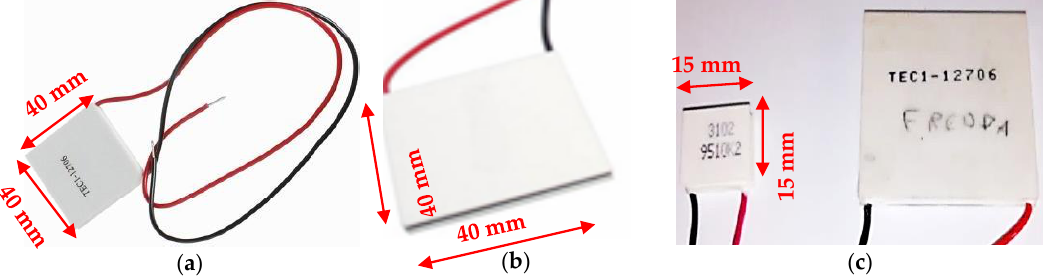
Figure 5. Top view of TEC1-12706 ( a ) (Thermonamic Inc.), TMG-127-1.4-1.2 (Ferrotec Nord Corp.) ( b ), and TES1-03102 MINI (Welletech Inc.) ( c ).